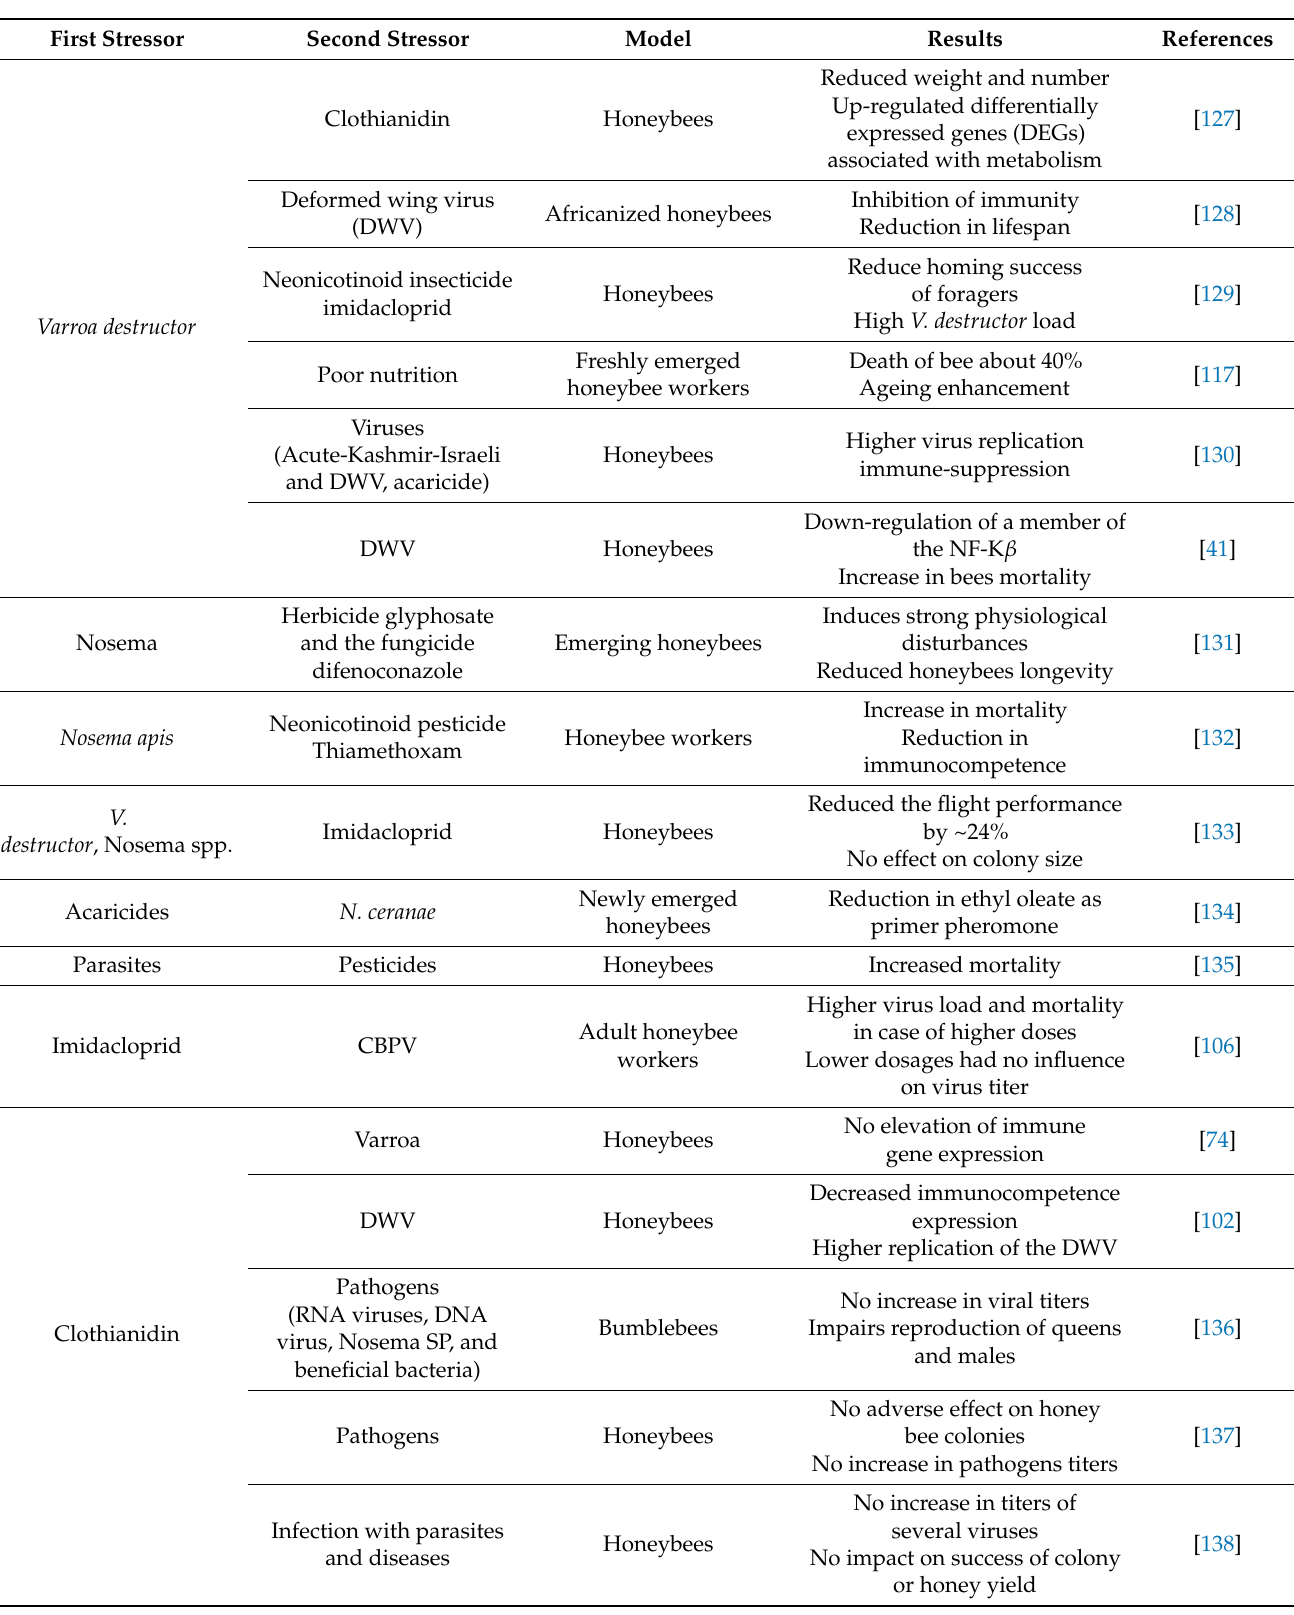
Table 2. Summary of field studies discussing the interaction between stressors on honeybees ( Apis mellifera